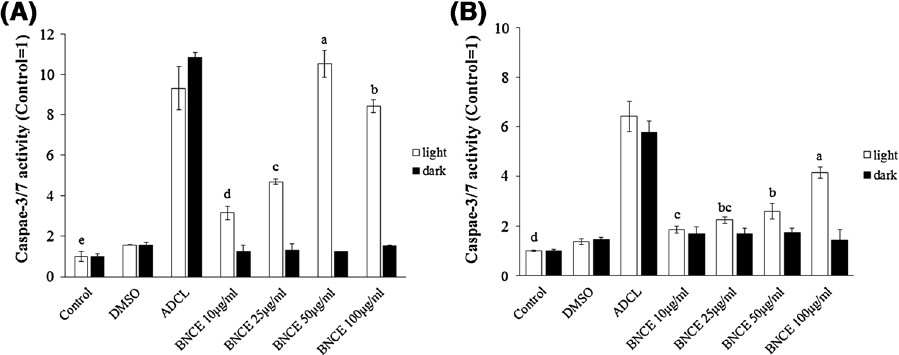
Fig. 3 Measurement of caspase-3/7 activity in U937 and SK-HEP-1 cells by BNCE and light treatment. Cells were treated with BNCE (10, 25, 50, and 100 l g/ml) for 4 h. Cells were irradiated with light for 10 min or kept in the dark, followed by incubation for 6 h. Caspase activity was determined by Caspase-Glo 3/7 assay. Results